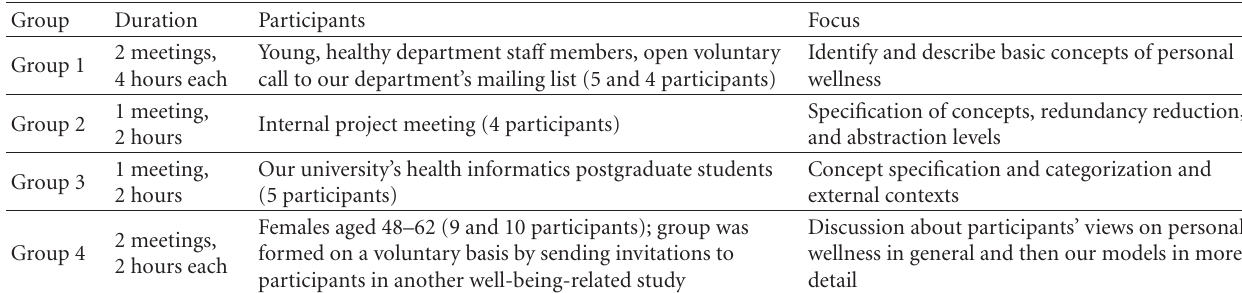
Table 1: Focus group